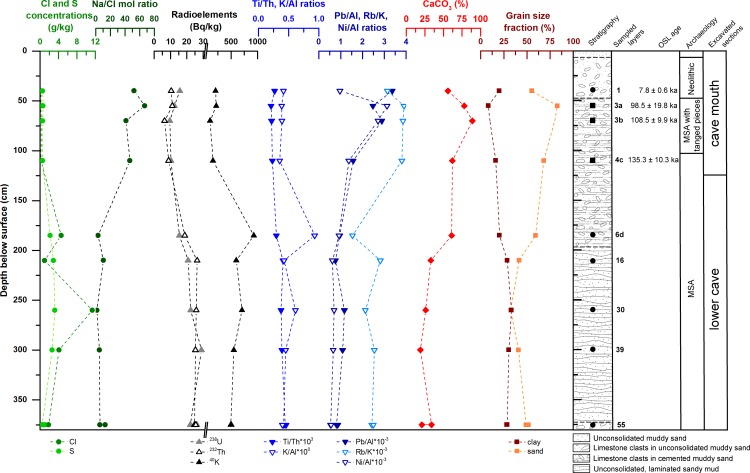
Sedimentological characteristics and stratigraphy of the Rhafas cave deposits.Results of XRF analyses, high resolution gamma spectrometry, calcium carbonate and grain size determination are displayed for each sampled layer from the cave mouth and the lower cave section at Rhafas, together with the determined OSL ages and the corresponding archaeological information.